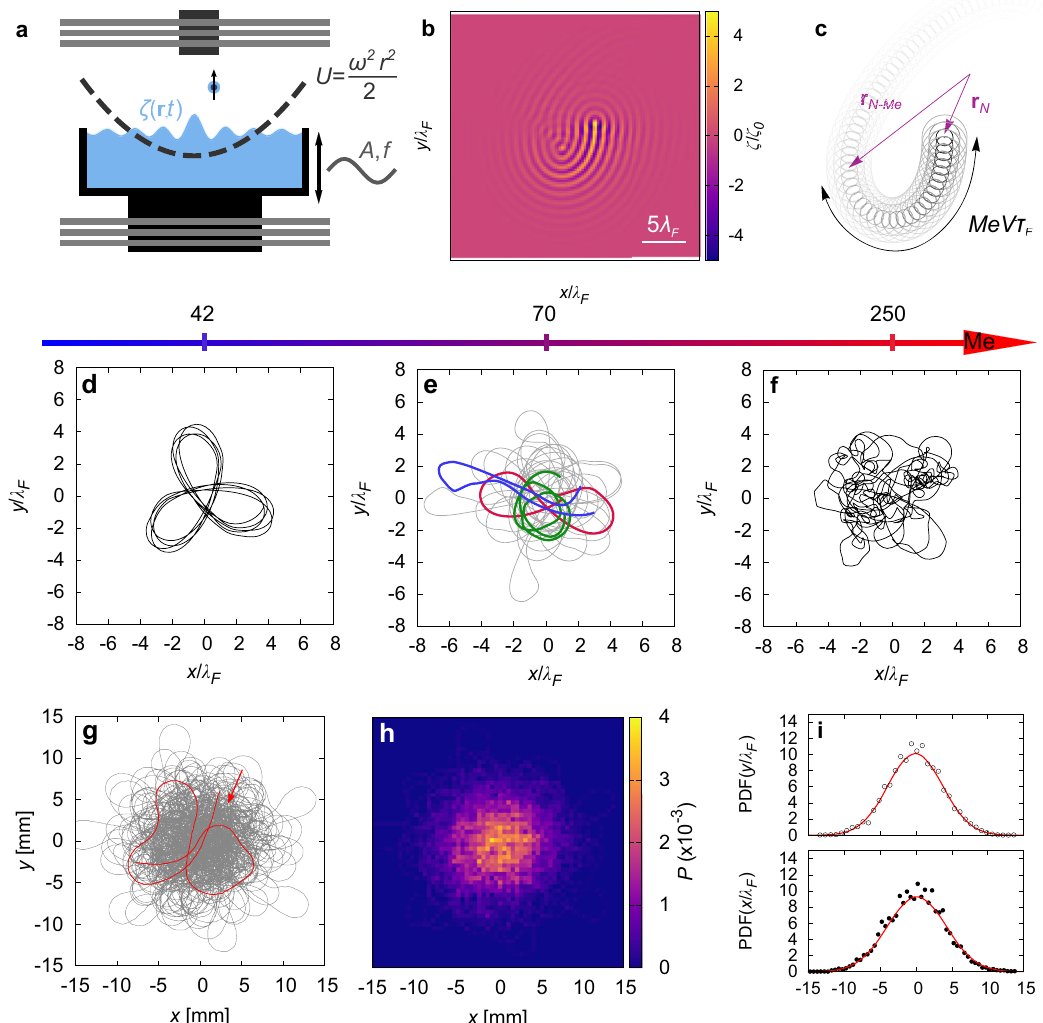
Fig. 1 Dynamics of a walker con fi ned in a harmonic potential in the high memory regime. a Schematic of the simulations and experiments. A drop of silicon oil bounces onto a silicon oil/air interface oscillating vertically at a frequency f and an amplitude A . Experimentally, the core of the droplet is made of ferro fl uid (see Methods). A set of coils in the Helmholtz con fi guration (light gray in the picture) generates a magnetic moment inside the ferro fl uid core (depicted by a arrow). An additional permanent magnet (dark gray on the fi gure) applies a harmonic potential on the walker, con fi ning it in the center of the experimental set up. b , c Illustration of the wave fi eld and associated trajectory. Decreasing gray scale is a qualitative indication of the wave sources intensity. The mean number of secondary sources contributing to the wave fi eld, Me, leads to a characteristic memory length, Me V τ F , with V being the mean speed, and τ F being the bouncing period and the frequency of the standing waves. d – f Simulated trajectories showcasing the many dynamics of the walker when Me increases for ω /2 π = 0.25 Hz. Low memory parameters ( d ) lead to self-organized trajectory and wave sources. Medium memory parameters ( e ) generate chaotic and intermittent trajectories: green trajectories represent circle motion, red accounts for lemniscates trajectories and blue for loops. The limit of large memory ( f ) shows erratic dynamics reminiscent of the dynamics observed in 40 . g , h Experimental trajectory of a walker and the corresponding stationnary probability density function for a frequency ω /2 π = 0.24 Hz and Me = 250. i Probability density functions for the position x and y of the walker in the case illustrated in ( g ). The black points are the experimental distribution and the red curve is a fi t by a Gaussian